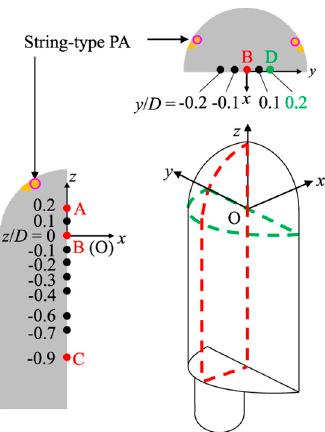
Figure 5. Locations of static pressure holes and coordinate systems for static pressure measurement.